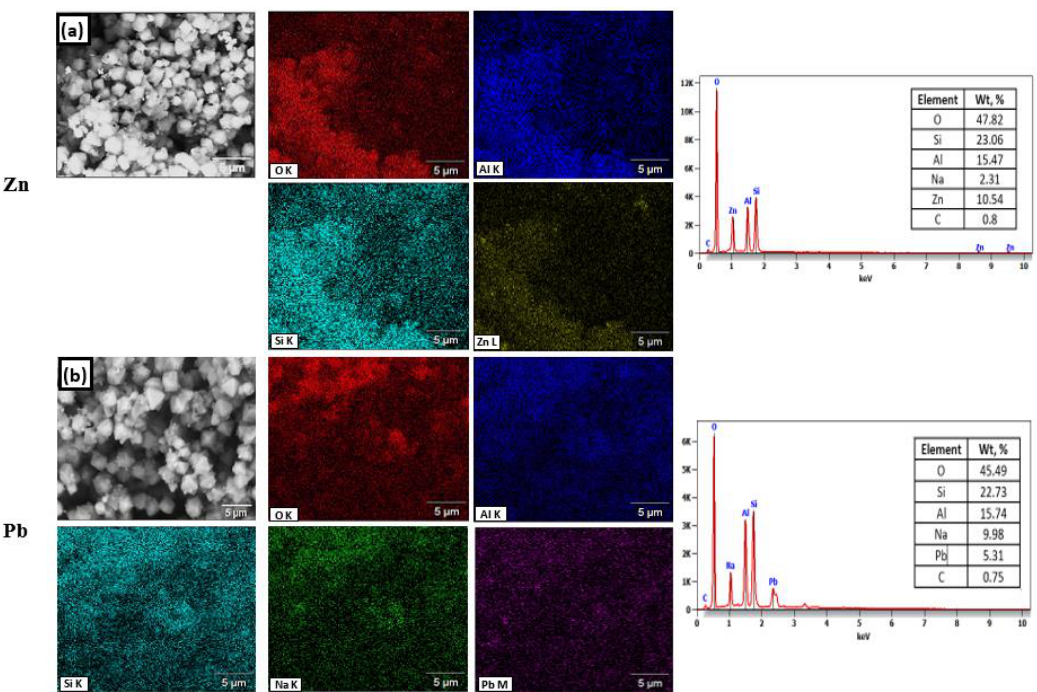
Figure 10. SEM image of the synthesized zeolite at SASR-Kaolin weight ratio of 1:1.5: ( a ) mapping of Zn 2+ loaded, O, Al, Si, Zn, and EDS element analysis, ( b ) mapping of Pb 2+ loaded, O, Al, Si, Na, Pb, and EDS element analysis. Nanomaterials 2023 , 13 , x FOR PEER REVIEW